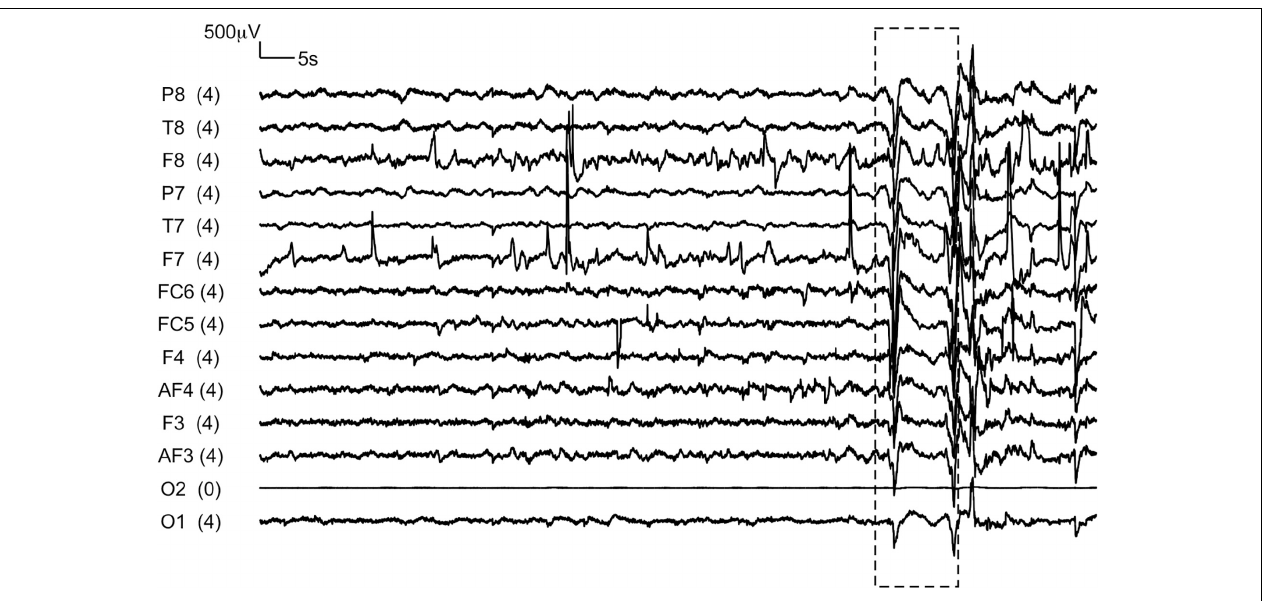
FIGURE 2 | A representative EEG trace recorded from a child during eyes-closed resting state condition. The box represents the section of the recording during which the assessor reported a disruption due to a loud sound in the testing